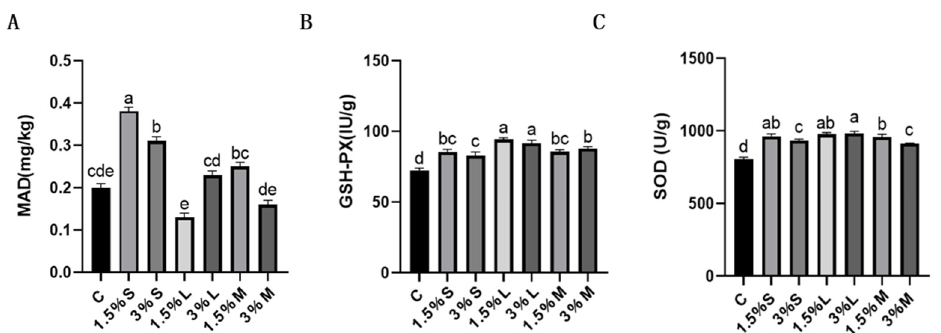
Figure 2. Each value is presented as mean ± SD, different superscript (a–e) indicates significant differences ( p < 0.05). The effect of different oils on MDA, SOD, and GPX in egg yolk. C: control group; 1.5% S or 3%: addition of 1.5% or 3% of soybean oil to the base diet, respectively; 1.5% L or 3%: addition of 1.5% or 3% of lard to the base diet, respectively; 1.5% or 3% M: addition of 1.5% or 3% of mixed oils to the base diet, respectively. ( A ): effect of different oils and fats on MDA in raw egg yolk; ( B ): effect of different oils and fats on GSH-PX in raw egg yolk; ( C ): effect of different oils and fats on SOD in raw egg yolk.